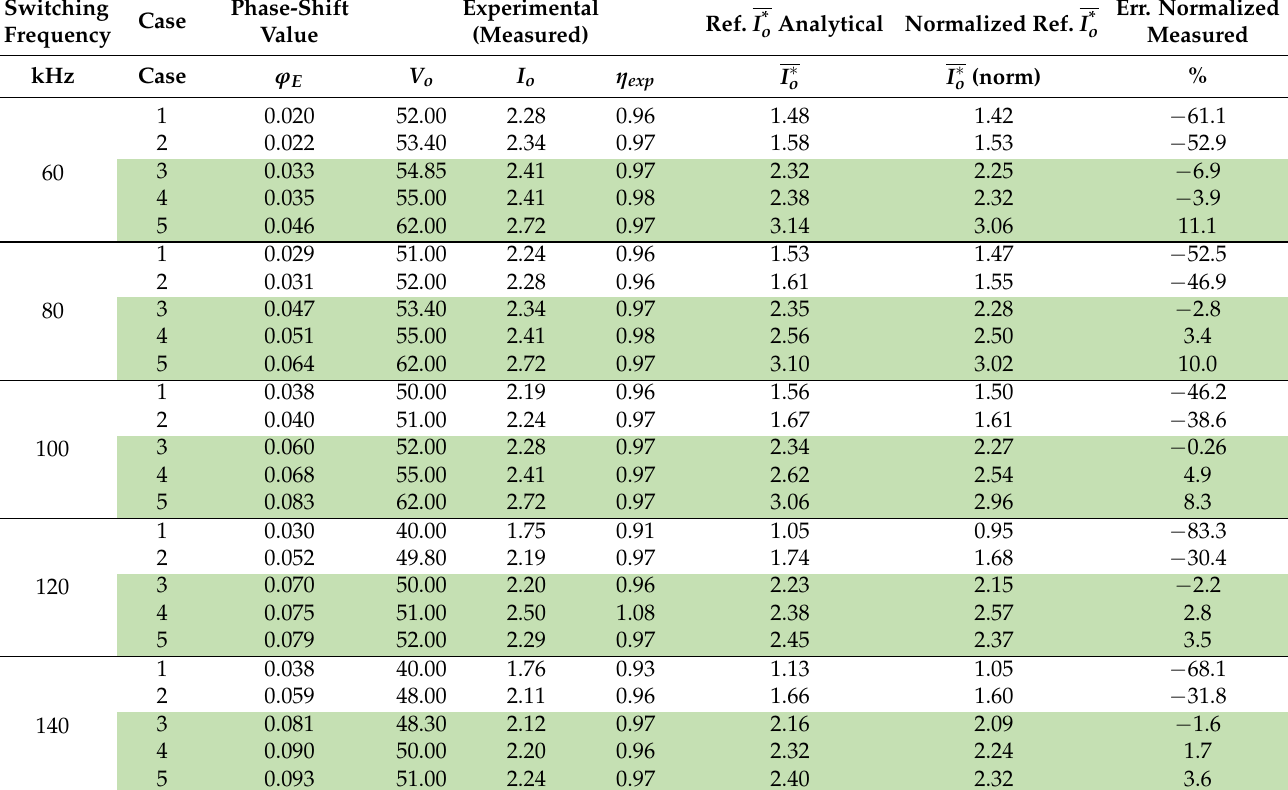
Table 4. SPS closed-loop test with variable switching frequency (60–140